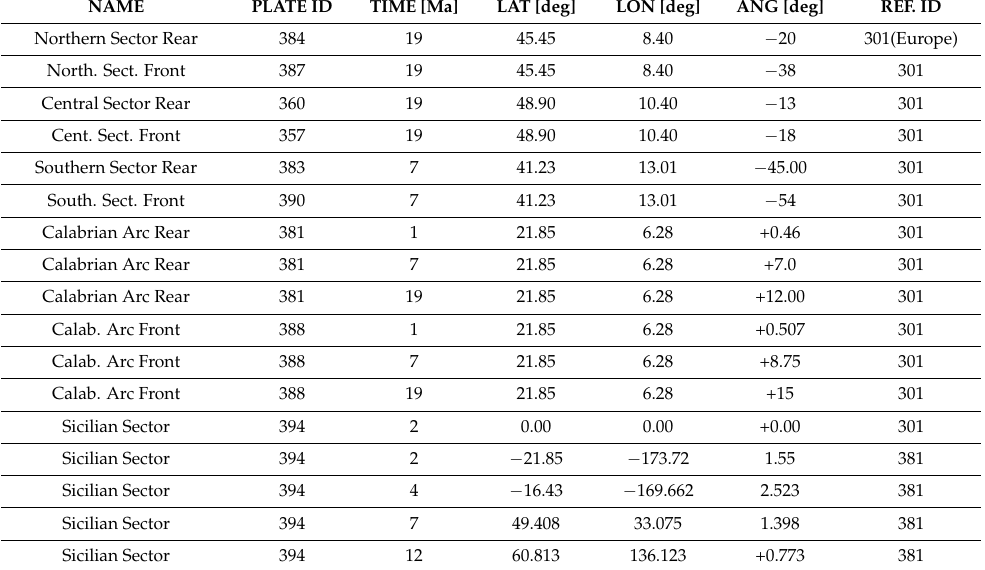
Table 1. Finite reconstruction parameters, from [27].